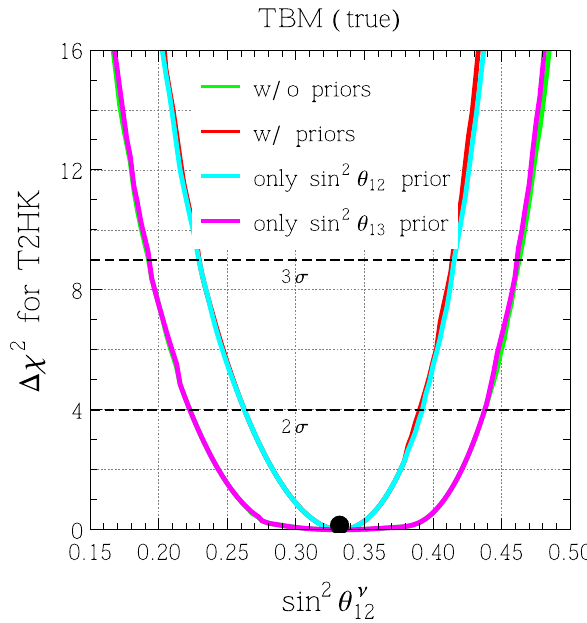
Fig. 4 Impact of external Gaußian priors on sin 2 θ 12 and sin 2 θ 13 on the resulting (cid:6)χ 2 function in the case of T2HK. We use a prior on sin 2 θ 12 of 0.7% (at 1 σ ) from JUNO and a prior on sin 2 θ 13 of 3% (at 1 σ ) from Daya Bay. While doing so, we assume the current best fit values of these two parameters to be their true values. The black dot = 1 / 3, which characterises the TBM symmetry corresponds to sin 2 θ ν 12 form